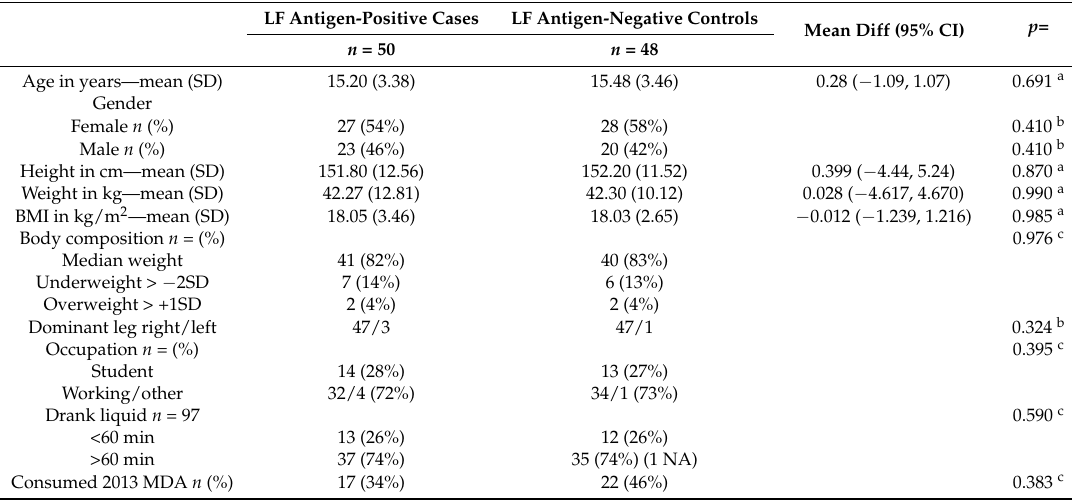
Table 1. Group characteristics of antigen-positive and antigen-negative participants (positive by either immunochromatographic test (ICT) or Og4C3) at